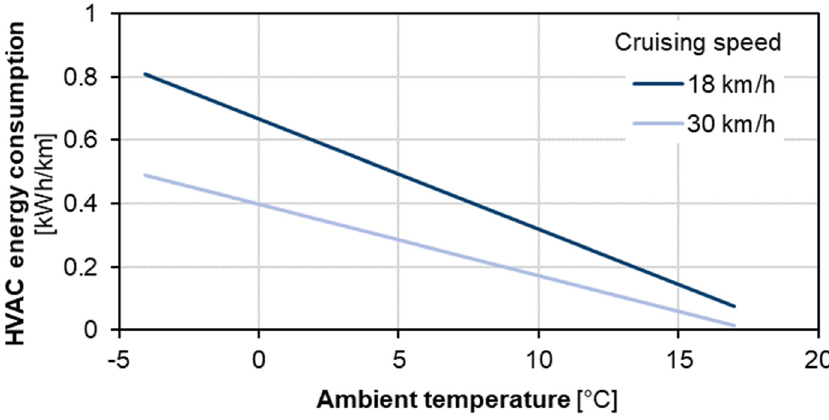
Figure 3. HVAC energy consumption as a function of ambient temperature (adapted from [56]).